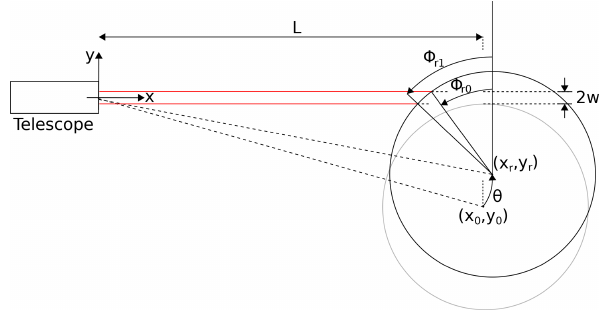
Figure 4. Schematic drawing used to derive the 2-D thick beam model. Notice that w is the beam radius and ( x 0 ,y 0 = L, − R − w ). whilst normalising by (cid:49)φ r : φ r 1 (cid:90) 1 1 (cid:1) . − sin φ r V LOS = V wheel cos φ d φ = V wheel (cid:0) sin φ r 1 0 (cid:49)φ r (cid:49)φ r φ r 0